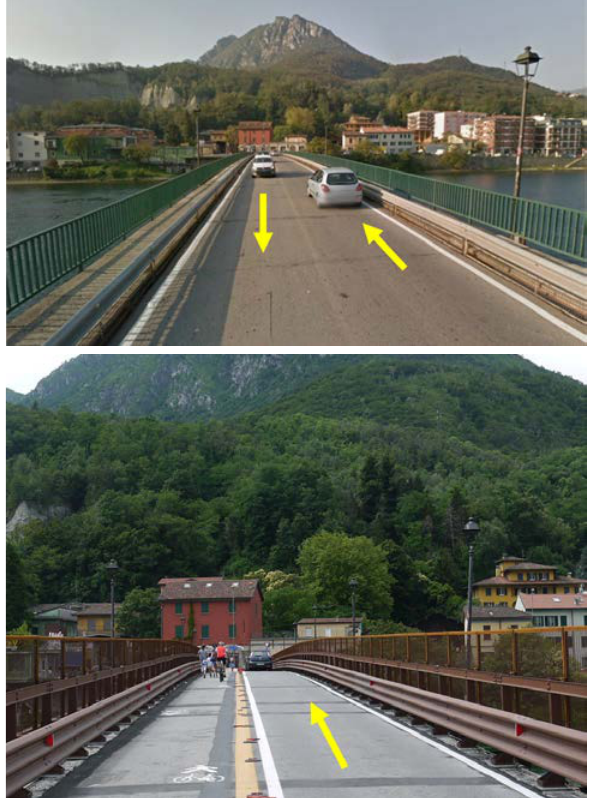
Figure 8. The bridge before and after the intervention: from two (top) to a single lane for cars (bottom), with a new pedestrian lane.